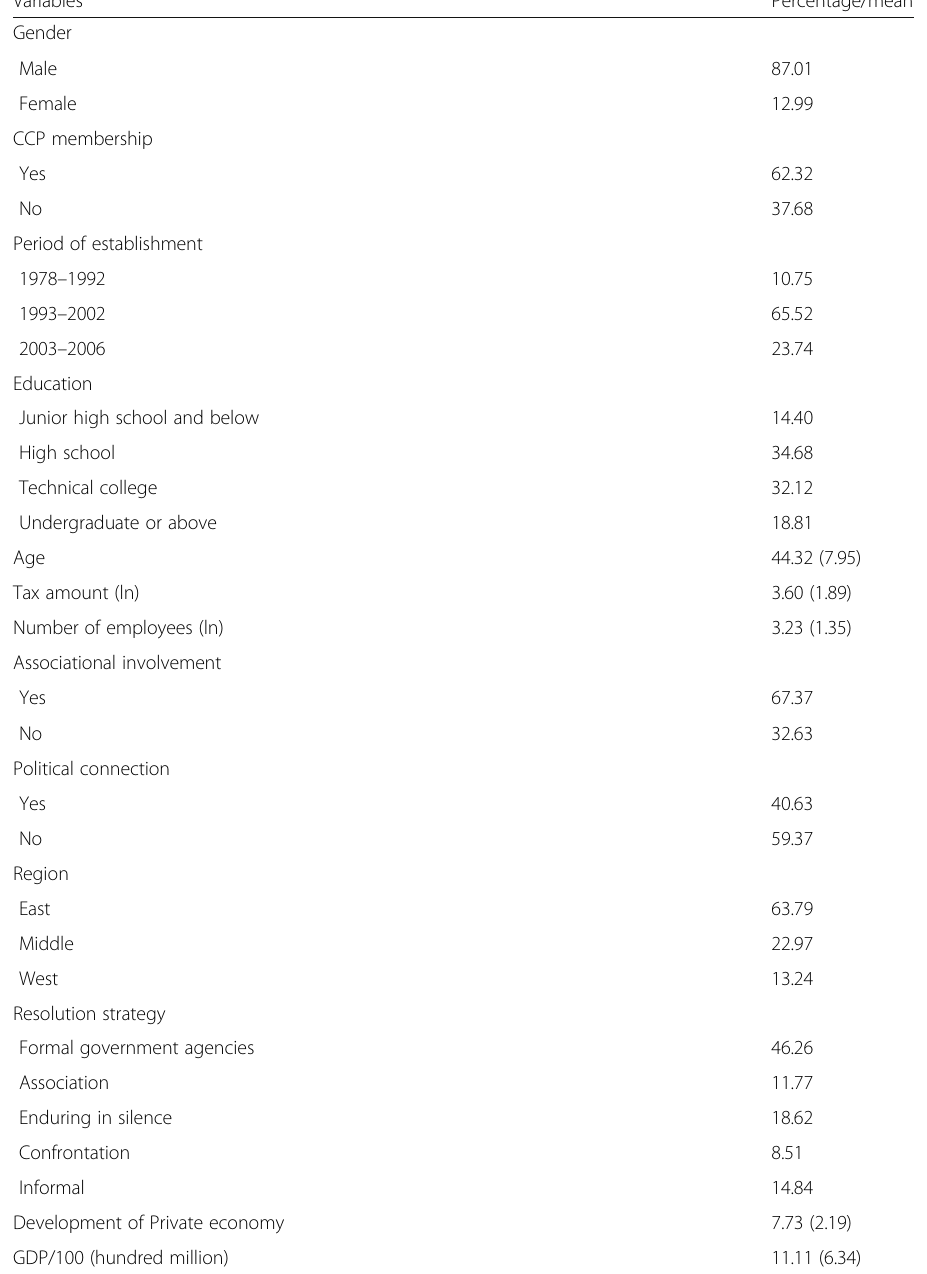
Table 2 Descriptive statistics ( N =